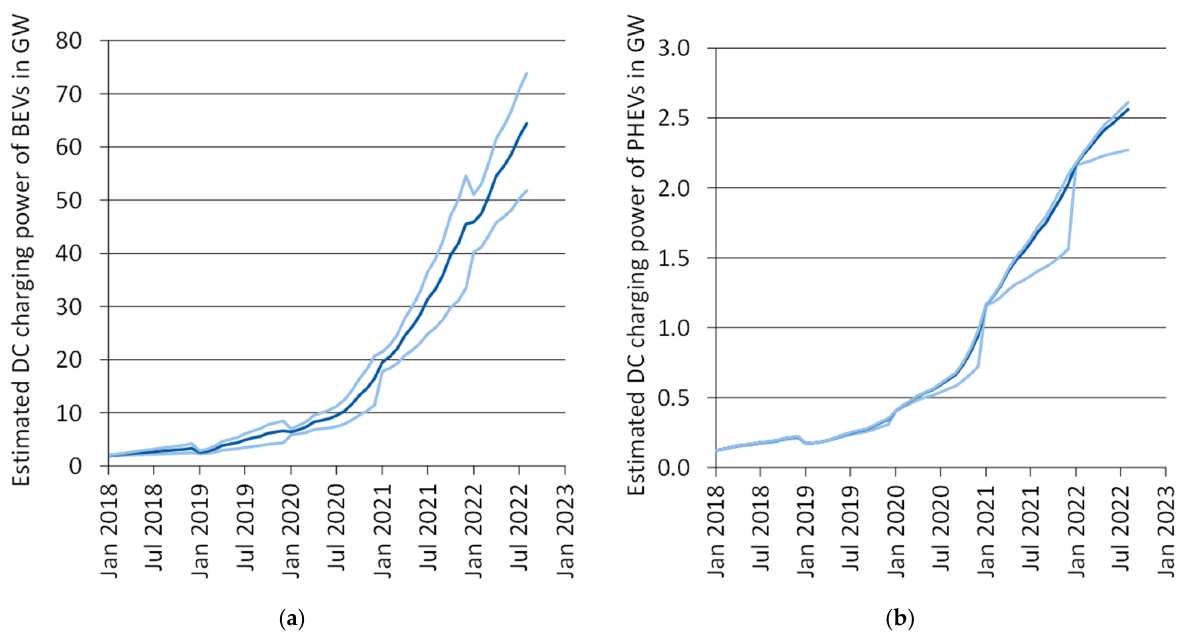
Figure 4. Estimated DC charging powers of ( a ) BEV fleet and ( b ) PHEV fleet. The surrounding light- blue lines are the error corridor that results from the fact that the national car registry’s identification system does not differentiate between the charging powers of different versions of a car model.